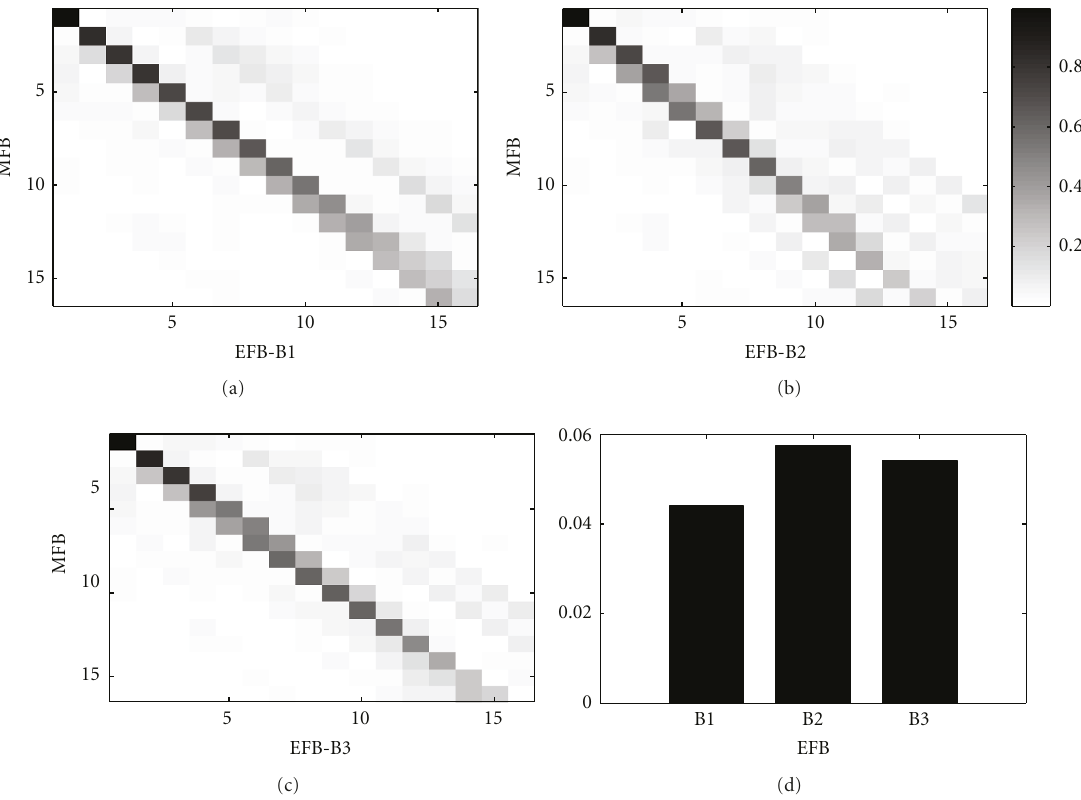
Figure 10: Squared Pearson’s correlation between MFCC and ESCC obtained with EFB-B1, EFB-B2, and EFB-B3 ((a), (b) and (c), resp.). Normalized sum of the correlation coe ffi cients outside the diagonal